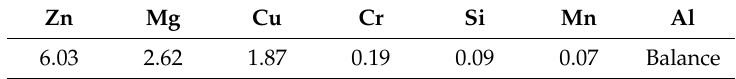
Table 1. Evaluated aluminum–zinc alloy UNS A97075-T6 composition (% weight). Zn Mg Cu Cr